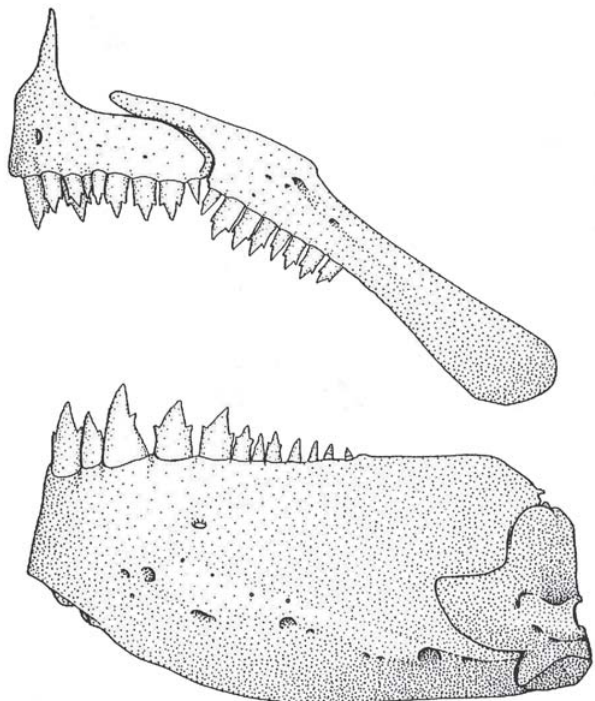
Fig. 35. Mimagoniates inequalis , adult male, MCP 9892, 37.0 mm SL; jaws and dentition, lateral view, right side, anterior at